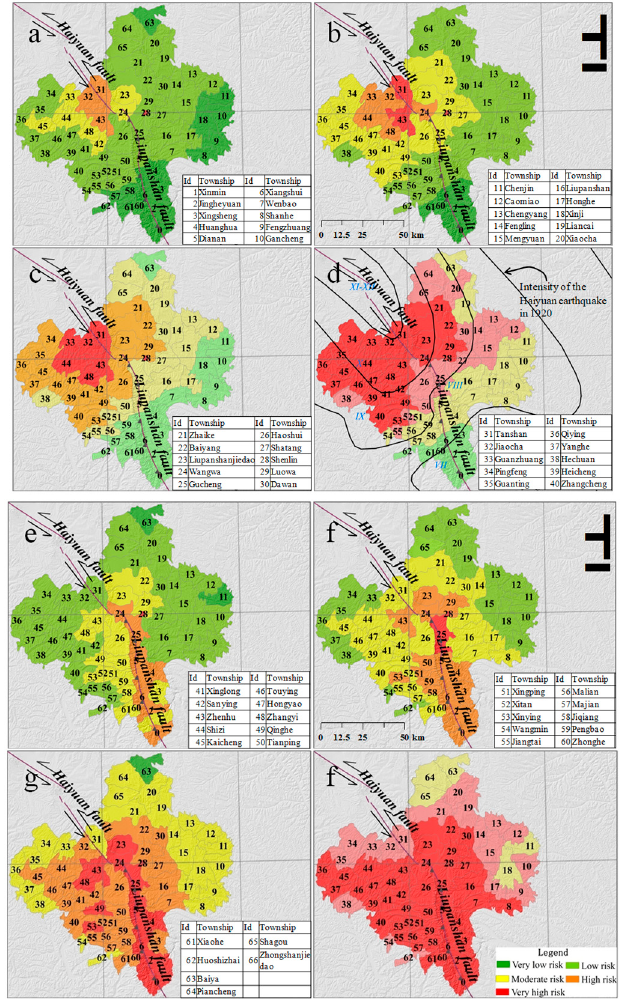
Figure 8. Risk assessment zoning maps in the Guyuan Region, at the township level, for a seismic scenario of Ms 7.0–8.5 along the Haiyuan Fault and the Liupanshan Fault: ( a – d ): A seismic scenario of Ms 7.0–8.5 along the Haiyuan Fault; and ( e – h ): A seismic scenario of Ms 7.0–8.5 along the Liupanshan Fault).